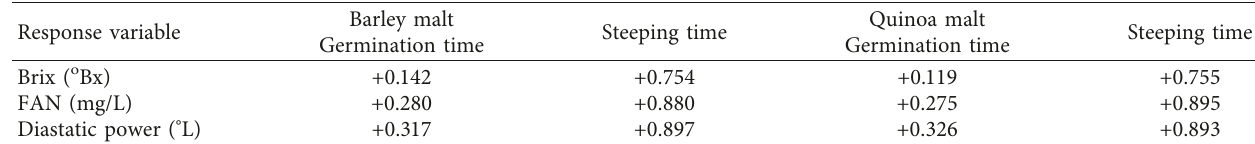
Table 7: Correlation coefficient ( r ) between independent and response variables during malting.